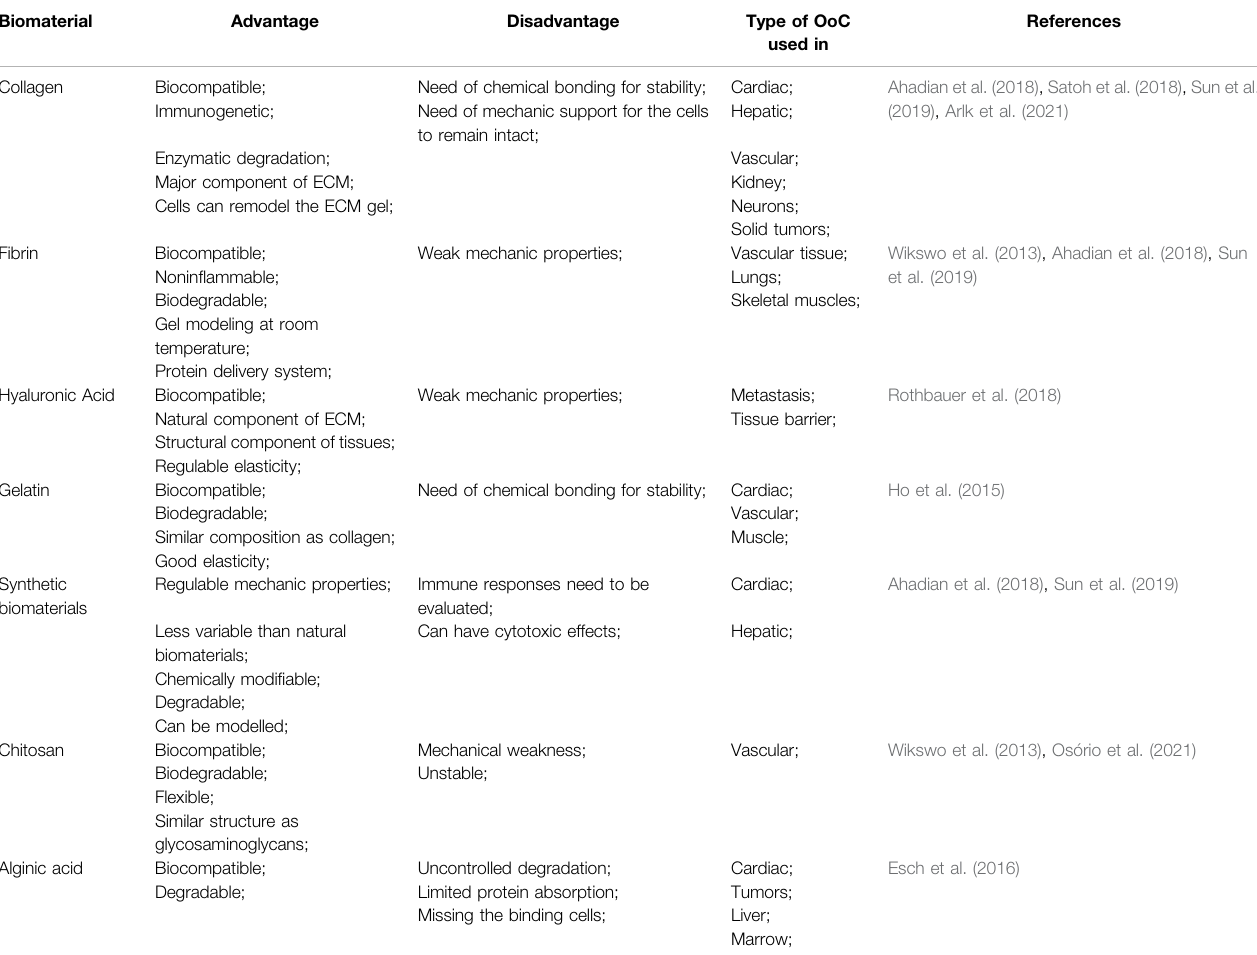
TABLE 2 | Summary of hydrogel-based